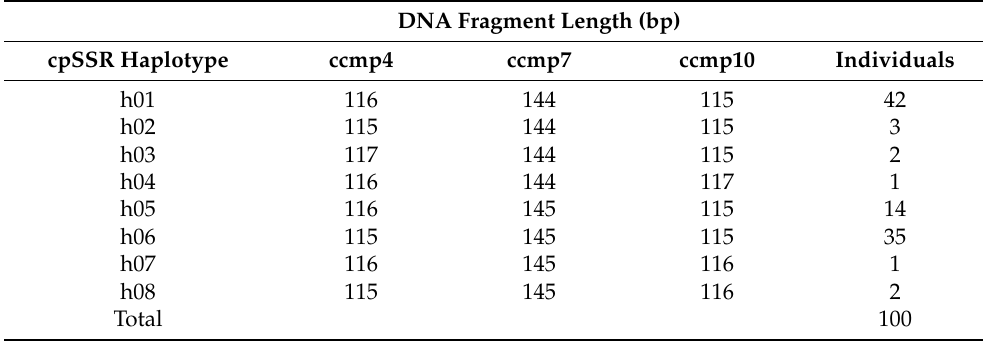
Table 2. Description and absolute frequencies of cpSSR haplotypes for beech in the Almopia basin. DNA Fragment Length